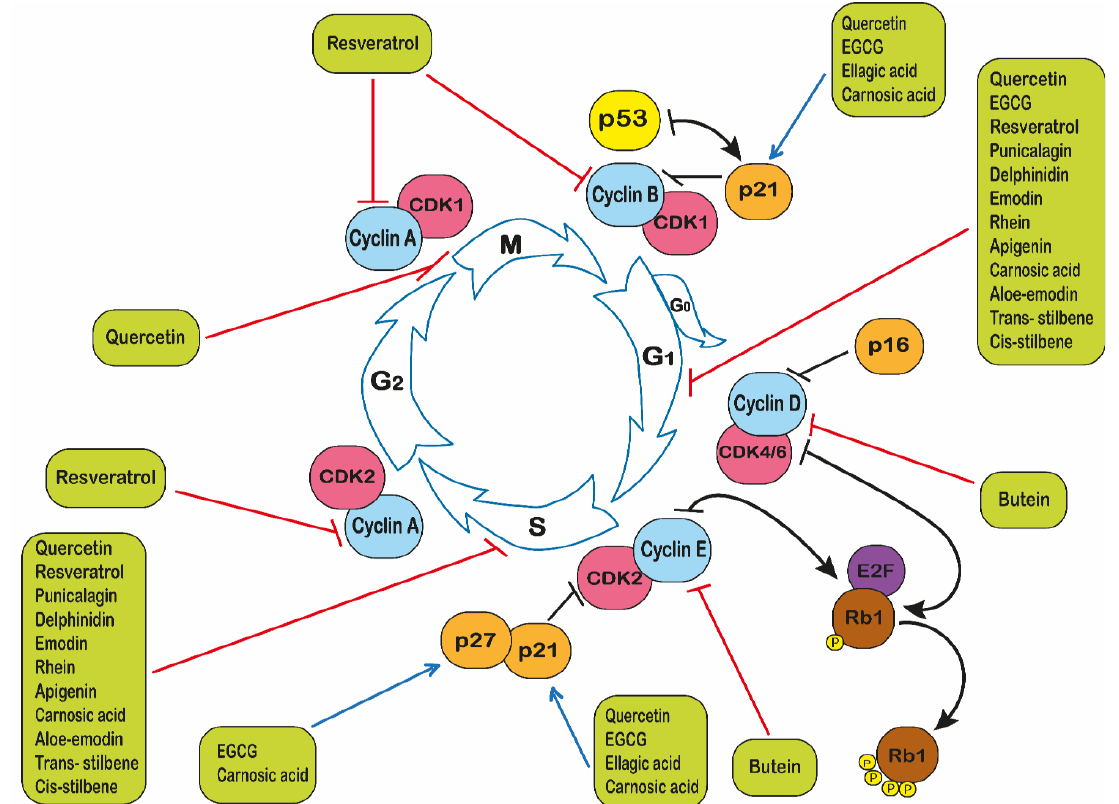
Figure 5. The modulation effect of polyphenols on the cell cycle. Cyclin dependent kinases (CDK) regulate the cell cycle, with cyclins. The CDK inhibitors are regulated by regulatory proteins: p21, p16 and p27 (shown in orange). The proto-oncogene P53 (show in yellow) regulates transcription factors via induction of p21 which is a CDK inhibitor. The retinoblastoma protein (pRb) (shown in brown) is an inhibitor of cell cycle progression from G 1 to the S phase of the cell cycle by interacting with E2F transcription factors (purple), this in turn is regulated by a cell-cycle dependent phosphorylation catalysed by cyclin-dependent kinases in the late G 1 phase of the cell cycle. The modulation effect of a variety of polyphenols (lime green) is shown by the red lines.